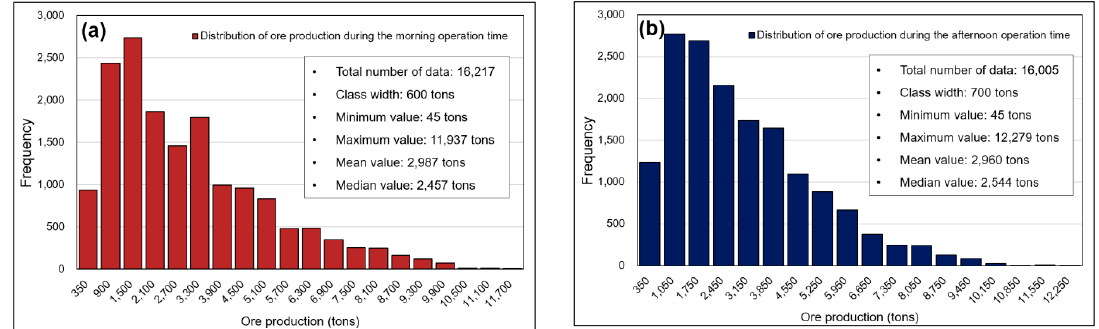
Figure 7. Histogram depicting distribution of ore production during ( a ) morning and ( b ) afternoon operation times. Table 2. Results of statistical analysis of training data.